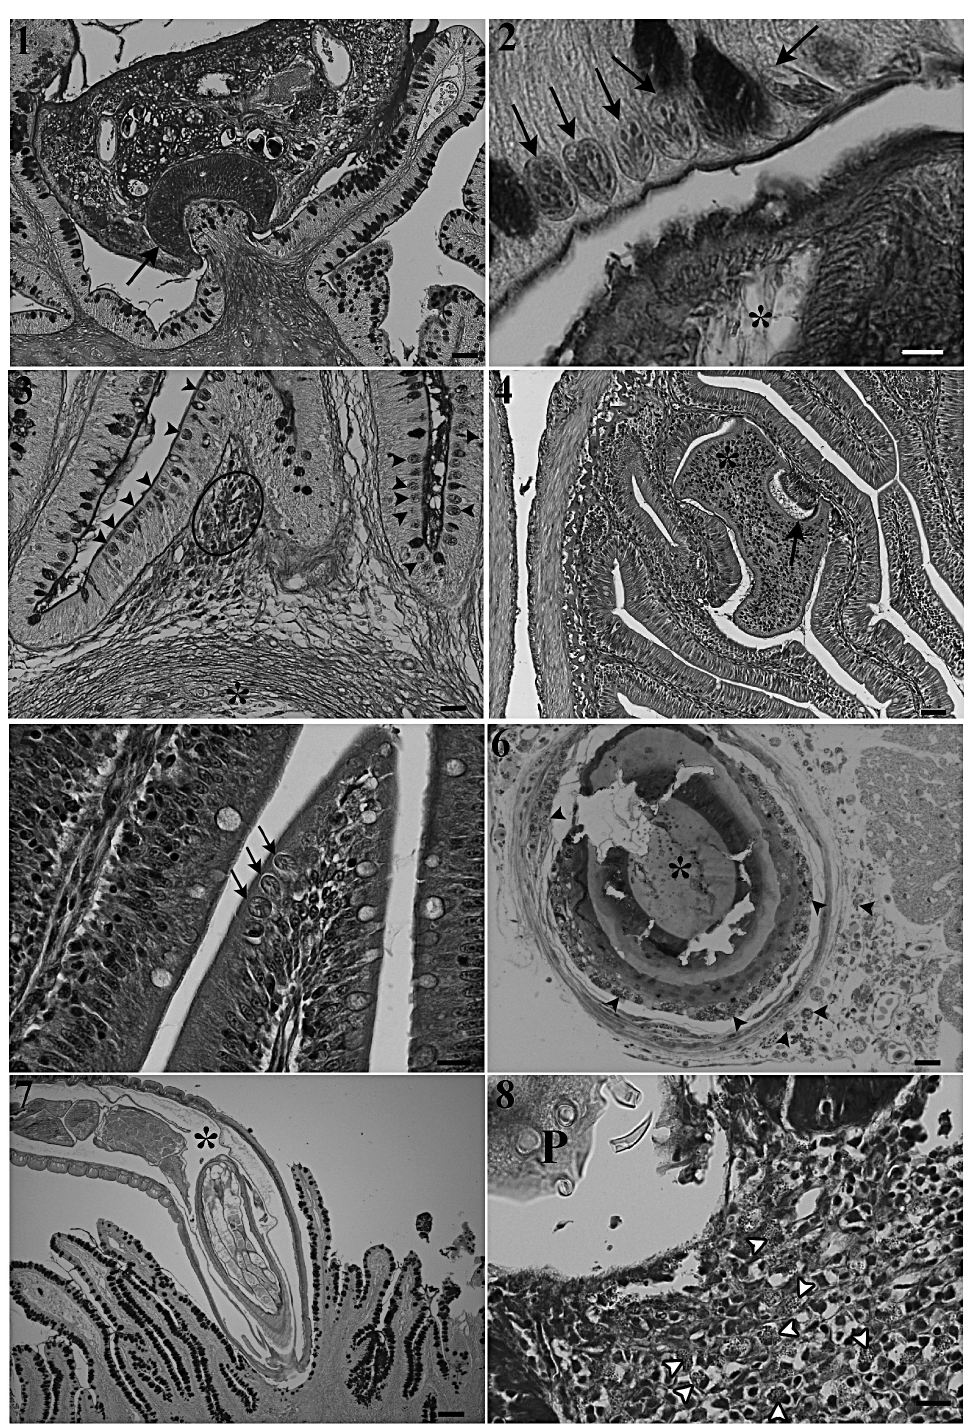
1-8. – Fig. 1. A specimen of Helicometra fasciata within eel intestinal fold. Inside the ventral sucker (arrow) the presence of a frag- ment of gut epithelium can be seen, scale bar = 60 µm. Fig. 2. Rodlet cells (arrows) in the apex of eel intestinal villi toward H. fasciata body (asterisk), scale bar = 10 µm. Fig. 3. Numerous rodlet cells (arrow heads) in eel epithelium and high number of mast cells (circle) very close to encysted Contracaecum rudolphii larva (asterisk), scale bar = 30 µm. Fig. 4. A cross-section through a caecum of Onco- rhynchus mykiss parasitized with Eubothrium crassum (asterisk). Attachment of the tapeworm scolex by its bothria (arrow) to the epithe- lium of the caecum is evident, scale bar = 60 µm. Fig. 5. Rodlet cells (arrows) noticed in the epithelium of the E. crassum -infected caecum, scale bar = 20 µm. Fig. 6. Coregonus lavaretus heart parasitized with Ichthyocotylurus erraticus metacercaria (asterisk), the cyst is sur- rounded by high number of host mast cells (arrow heads), scale bar = 30 µm. Fig. 7. Parasitized intestine of Salmo trutta with attached Echinorhynchus truttae (asterisk), in site of infection lack of intestinal folds is evident, scale bar = 150 µm. Fig. 8. Numerous mast cells (white arrow heads) near the site of attachment of the proboscis (P), scale bar = 20